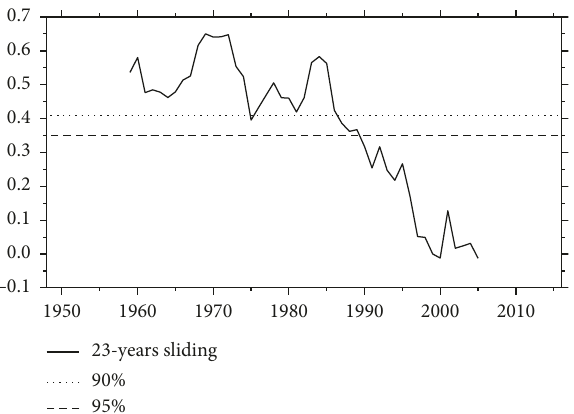
Figure 2: The 23-year sliding correlation coefficient between APOI and EASMI during 1948–2016. The long- and short-dashed lines indicate the values significant at the 90% and 95% confidence level,